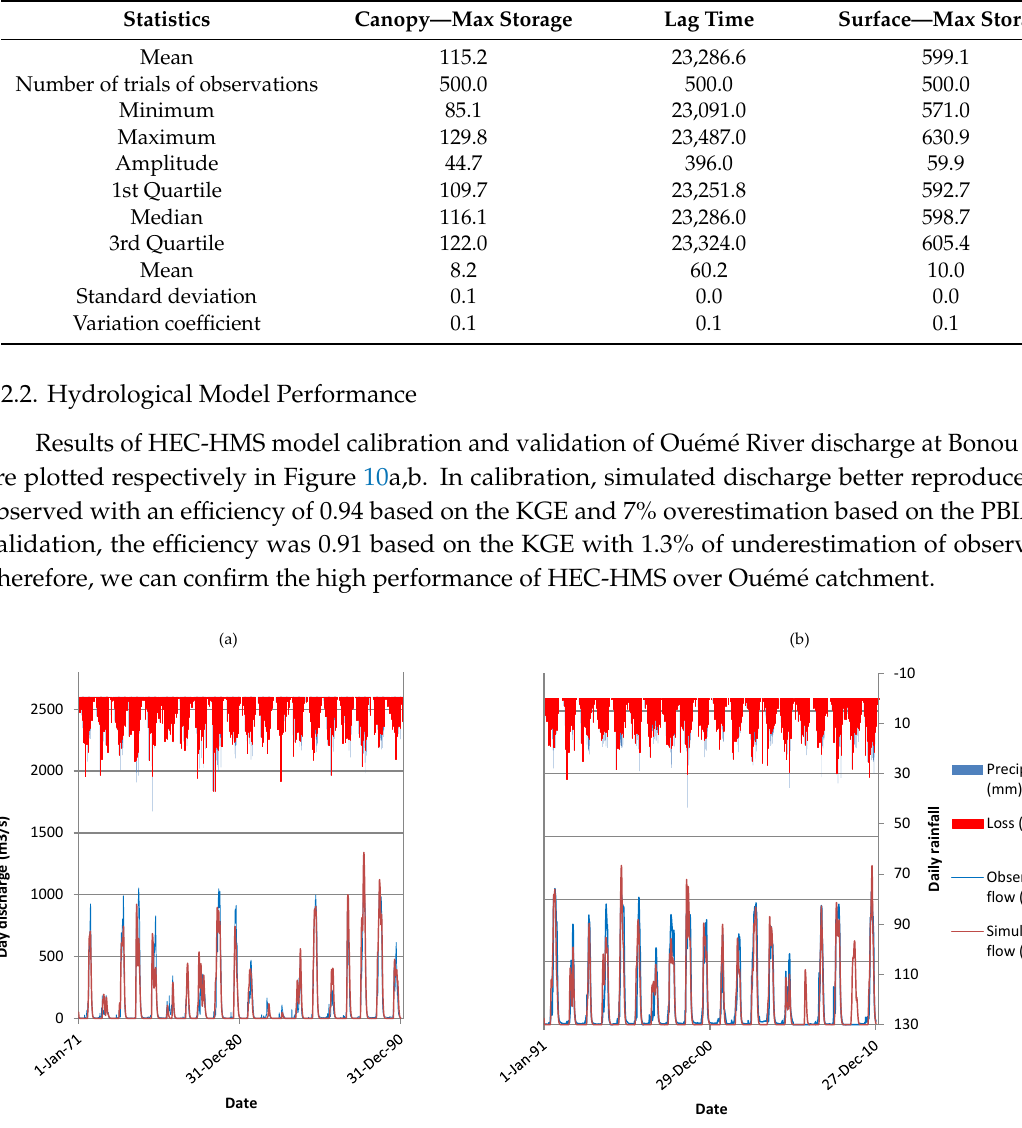
Figure 10. Hydrological model calibration from 1971–1990 ( a ) and validation over 1991–2010 ( b ) graphs.